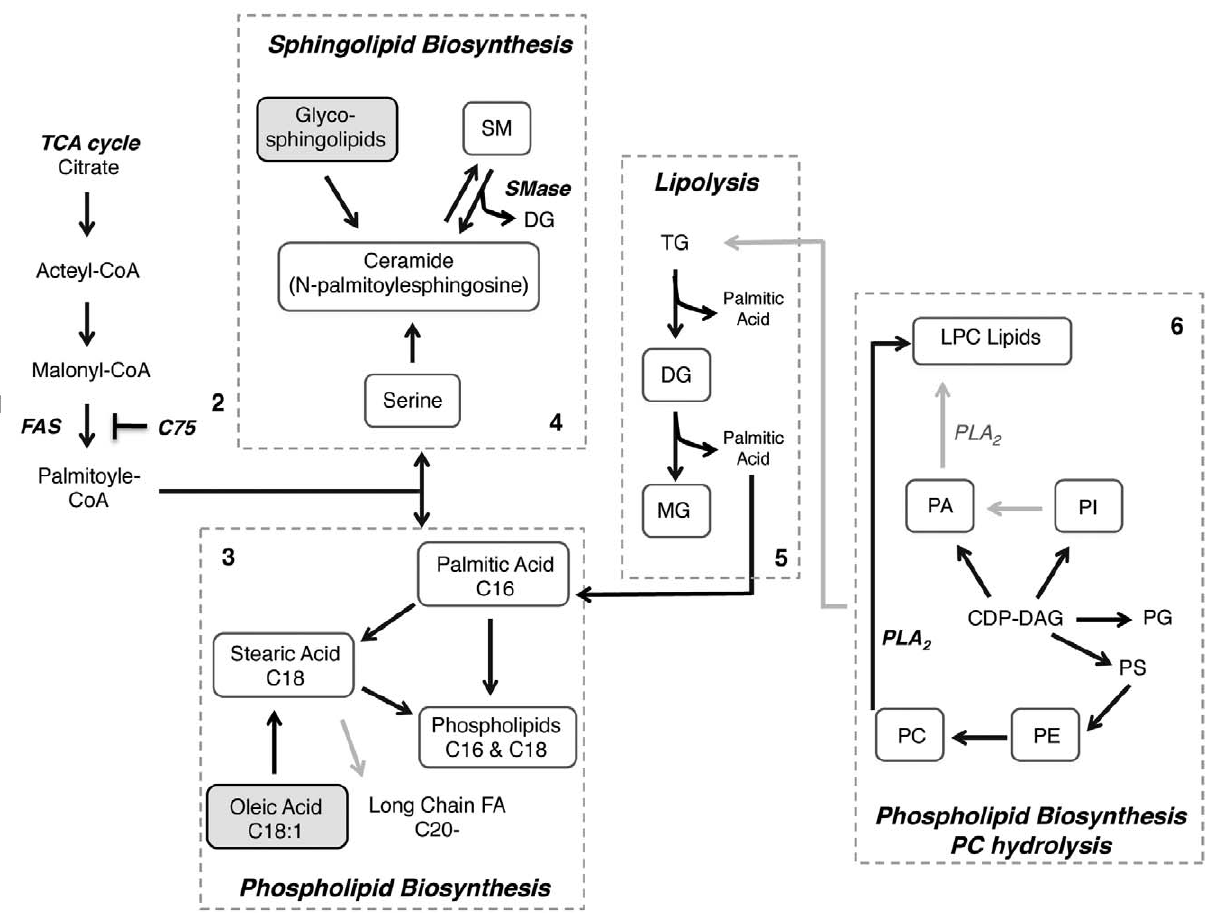
Figure 8. Dengue virus infection perturbs lipid homestasis in infected mosquito cells. The lipidomic analyses of dengue virus infected C6/ 36 mosquito cells suggest several metabolic pathways that may be significantly up regulated during infection. The grey dashed line highlights specific pathways of interest. Black arrows highlight reactions suggested by the lipidomic data and grey arrows represent reactions not observed in the data. Metabolites highlighted in boxes (solid line) are up regulated (white) or down regulated (grey) in DENV infected mosquito cells. 1. Through the recruitment and activation of FAS, DENV stimulates de novo phospholipid biosynthesis in the replication complex [20]. 2. Inhibition of this process with C75 disrupts the cellular lipid repertoire in mosquito cells to be unfavorable for virus replication. 3. The lipidomic analyses reveal an up regulation of fatty acids such as palmitic (C16) and stearic (C18) acid. These fatty acids are intermediates in the biosynthesis of phospholipids, which is up regulated during DENV infection. Interestingly, in DENV infected cells the prevalent phospholipids primarily consist of C16 and C18 unsaturated acyl chains. Very long chain fatty acids are not significantly up regulated during infection. 4. FAS activity also stimulates de novo sphingolipid biosynthesis. In the lipidomic analyses, the up regulation of intermediates such as N-palmitoylesphingosine suggests sphingolipid biosynthesis is activated during DENV infection. Specifically, SM and CER are enriched in DENV infected cells. Alternately, the up regulation in CER (and DG) during infection could result from the degradation of SM through the activity of sphingomyelinases (Smase). The resulting CER and DG could be redirected into several signaling pathways or be utilized for de novo phospholipid biosynthesis. The glycopshingolipids, GlcCER and GalCER are down regulated during DENV infection, which suggest that they are catabolized to produce CER. 5. Lipidomic analyses also suggest the up regulation of triacylglycerol catabolism (Lipolysis) in DENV infected cells. This pathway results in the generation of MG, DG and palmitic acid. These intermediates are all up regulated in DENV infected cells and could be utilized for downstream signaling or de novo phospholipid biosynthesis. It has also been shown that TG catabolism is necessary for mitochondrial b -oxidation during DENV infection [50]. 6. Elevated levels of LPC in DENV infected cells also suggest activation of PC hydrolysis by PLA 2 . This enzyme is activated during DENV infection. The elevated levels of other phospholipids such as PA,